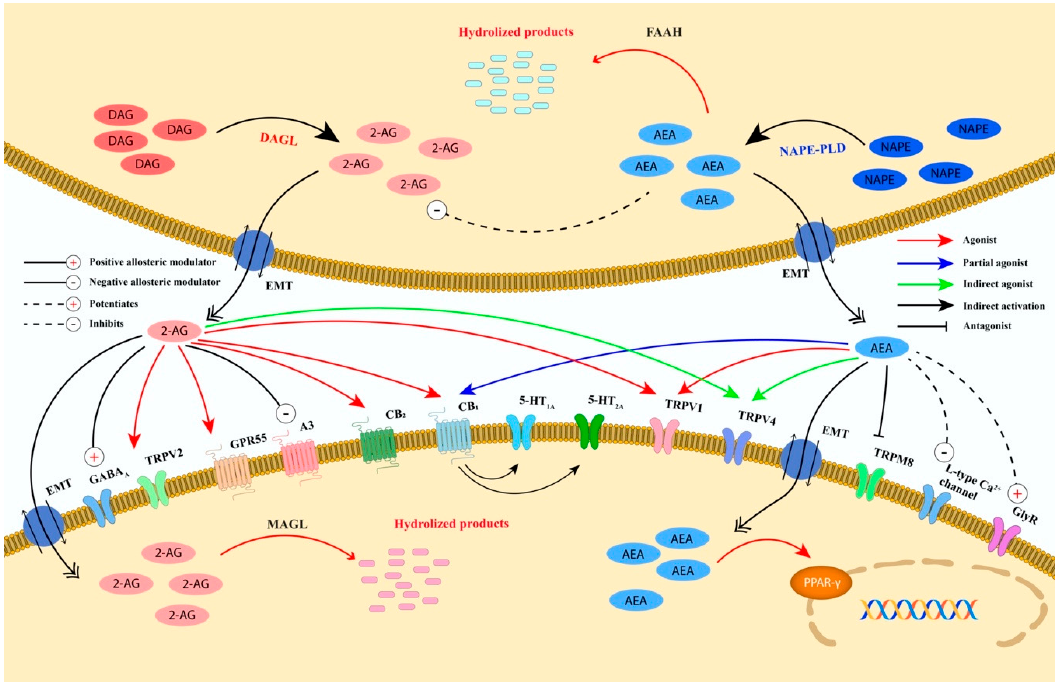
Figure 3. Schematic representation of the biosynthesis, degradation, and receptors’ binding of AEA and 2-AG. Anandamide and 2-AG are postsynaptically biosynthesized from the membrane’s phospholipids and degraded with different pathways and enzymes. AEA is mainly synthesized from NAPE by NAPE-PLD, whereas 2-AG is biosynthesized from DAG by DAGL- α and DAGL- β . The degradation of AEA is catalyzed by FAAH that is mainly expressed postsynaptically. 2-AG is degraded by MAGL that is expressed presynaptically and by two hydrolases named ABHD6 and ABHD12, expressed postsynaptically. Furthermore, AEA and 2-AG catabolism might also occur by the activity of other enzymes (e.g., NAAA, COX-2, and several LOX isoenzymes). AEA and 2-AG retrogradely activate presynaptic CB1. AEA is almost inactive on CB2, whereas 2-AG acts as a full agonist. In addition, AEA, directly or indirectly, also modulates the receptors/channels CB1, CB2, TRPV1 (at postsynaptic and presynaptic level), TRPV4, TRPM8, PPAR γ , 5-HT 1A , 5HT 2A , L-type Ca 2+ channel, GlyR and negatively regulates 2-AG biosynthesis. 2-AG, directly or indirectly, modulates the receptors/channels TRPV1, TRPV2, TRPV4, GPR55, A3 adenosine , GABA A , 5-HT 1A ,